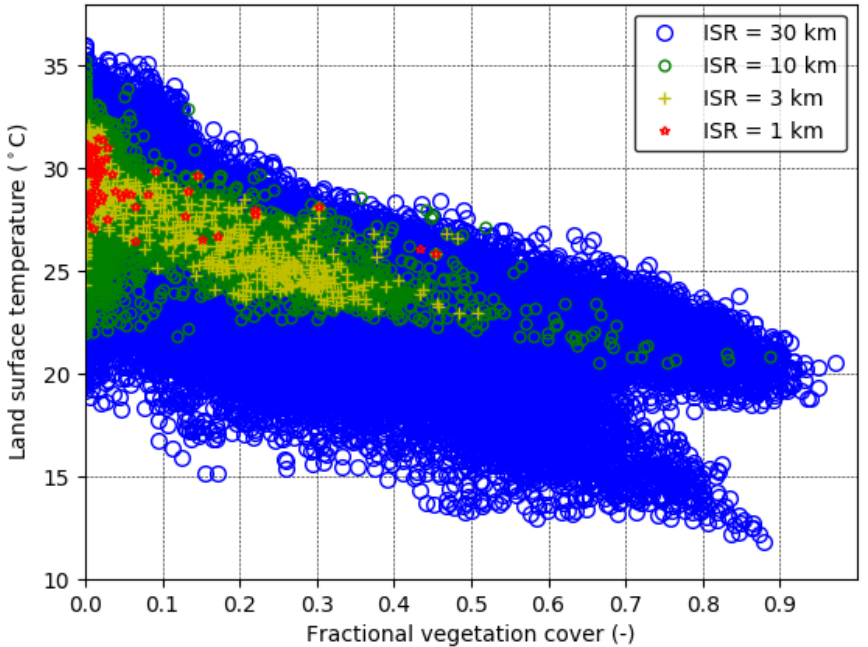
Figure 4. The LST- f v feature space is plotted for 100 m resolution pixels within a 30 km, 10 km, 3 km and 1 km ISR